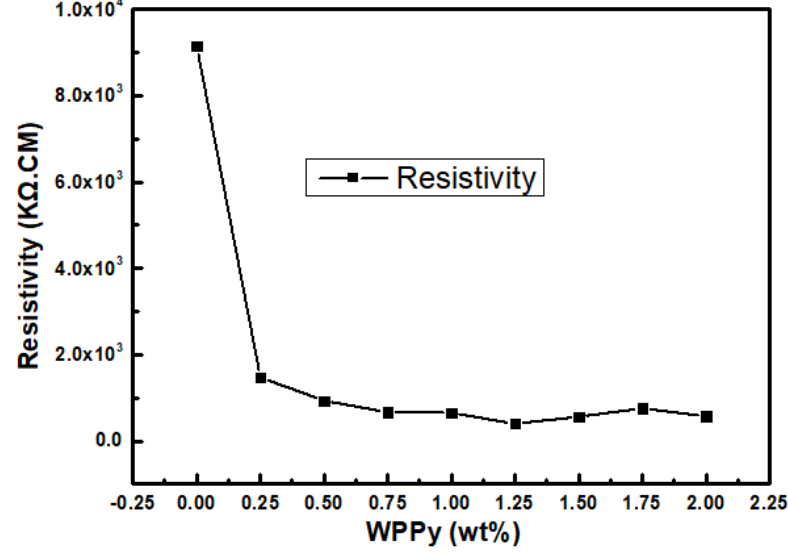
Figure 10. Resistivity of WPPy/cement composites in dry condition.